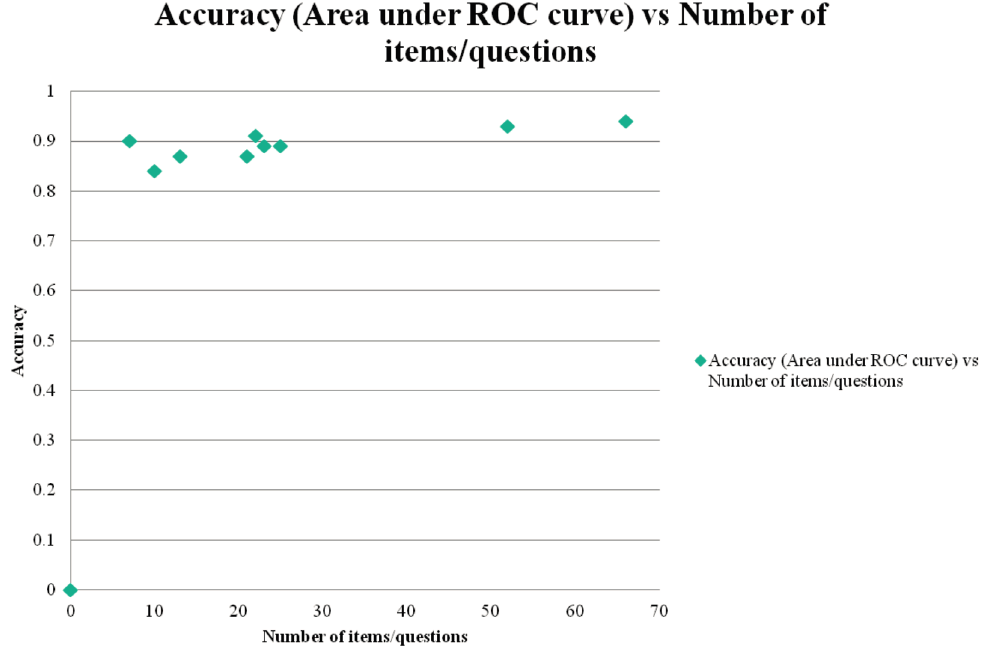
Figure 4. Scatter plot of area under ROC curve versus total number of test items/questions (= surrogate measure of test administration